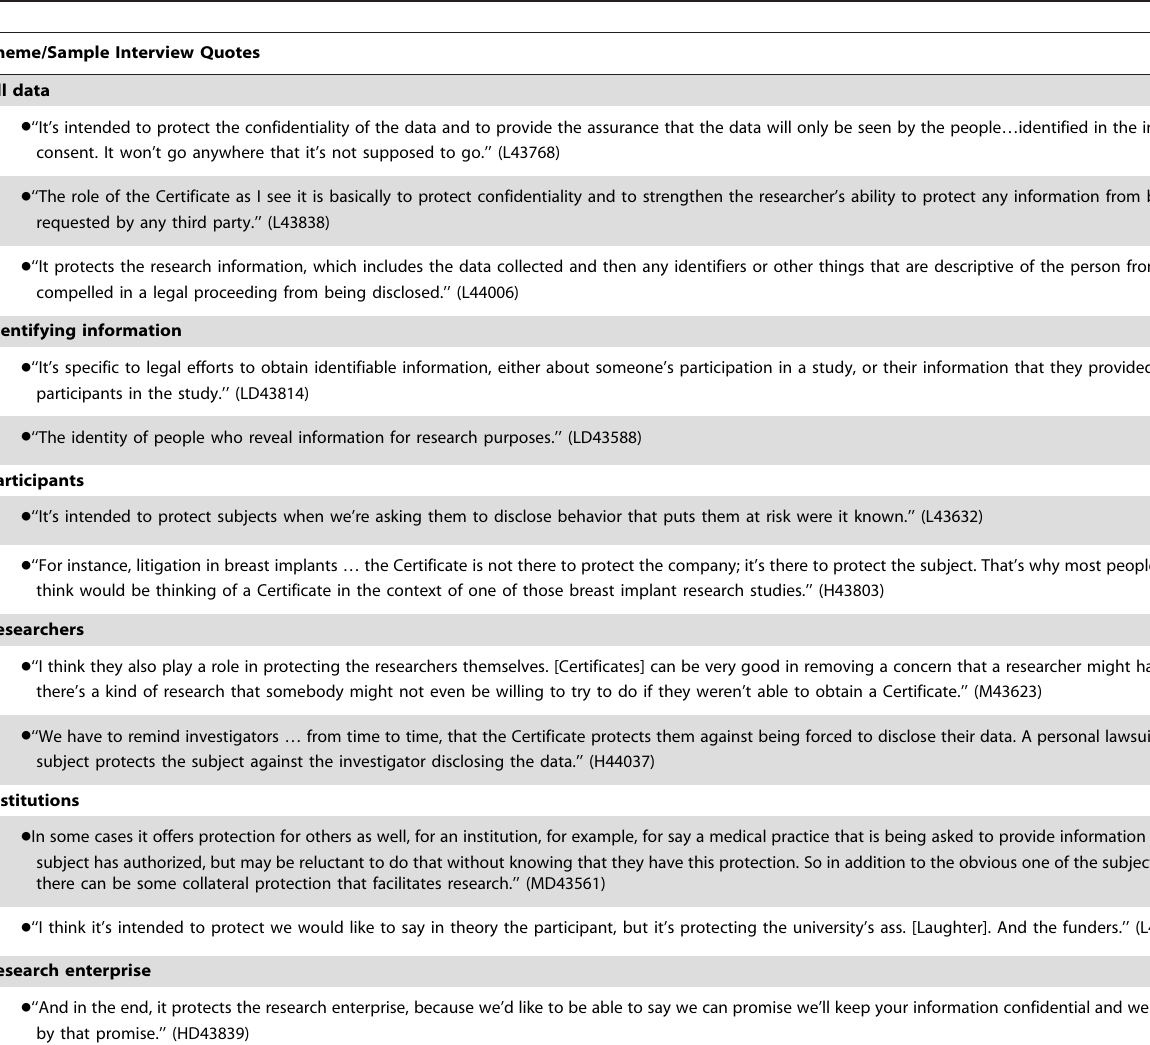
Table 3. ‘‘What–to your mind–are Certificates intended to